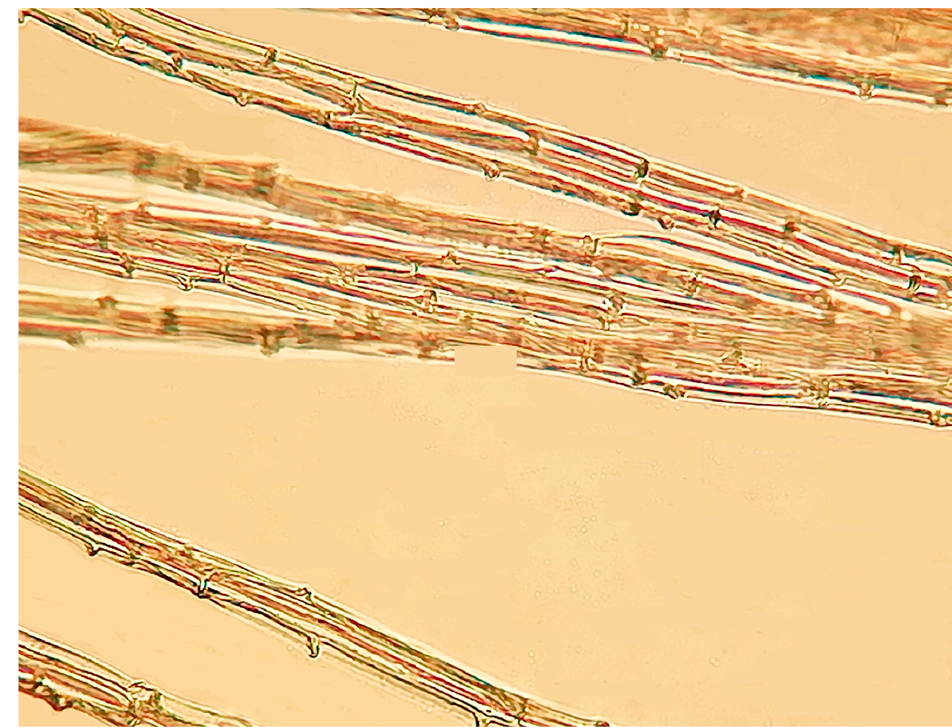
Figure 5. Typha lepechinii sp. nov.: gynophore’s hairs. Photo: O. A. Kapitonova.